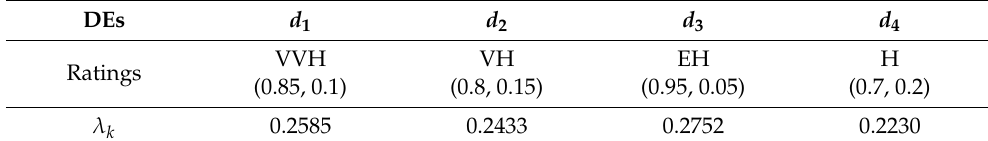
Table 3. The DE’s weight for prioritizing BESS.